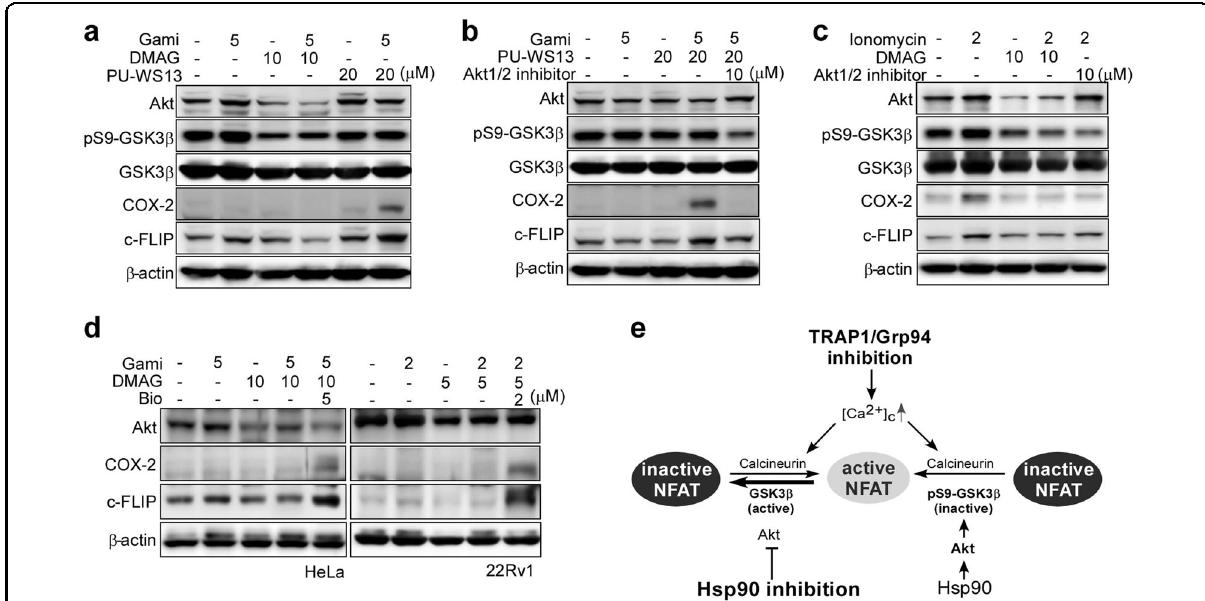
Fig. 5 Akt inactivation blocks calcium/calcineurin-induced NFAT survival signals by activating GSK3 β . a Decreased calcineurin/NFAT signaling upon degradation of Akt induced by Hsp90 inhibition. HeLa cells were incubated for 6 h with drugs and then analyzed by western blotting. b Decreased calcineurin/NFAT signaling upon Akt inactivation. HeLa cells were incubated for 6 h with drugs and then analyzed by western blotting. c Ionomycin induces calcium-mediated NFAT signaling. HeLa cells were incubated for 6 h with drugs and then analyzed by western blotting. d GSK3 β -mediated NFAT signaling in cancer cells after combined drug treatment. HeLa and 22Rv1 cells were incubated for 6 h with drugs and then analyzed by western blotting. e Overview of Hsp90 paralog inactivation and NFAT